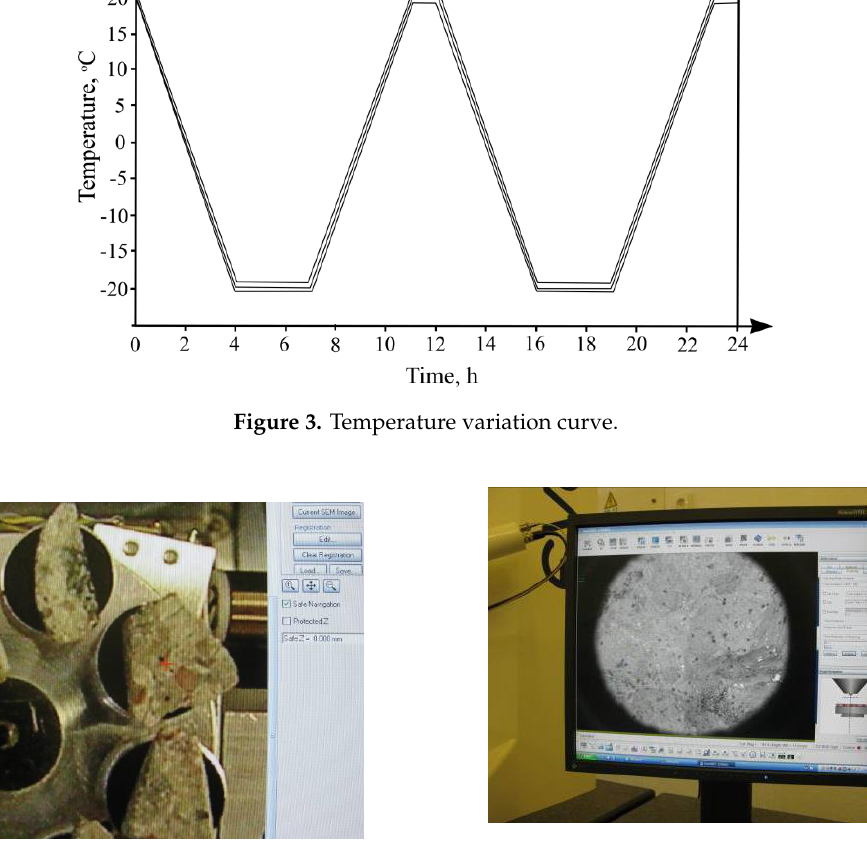
Figure 4. View of SEM search system: ( a ) real view of samples: ( b ) view of sample placed in the microscope.